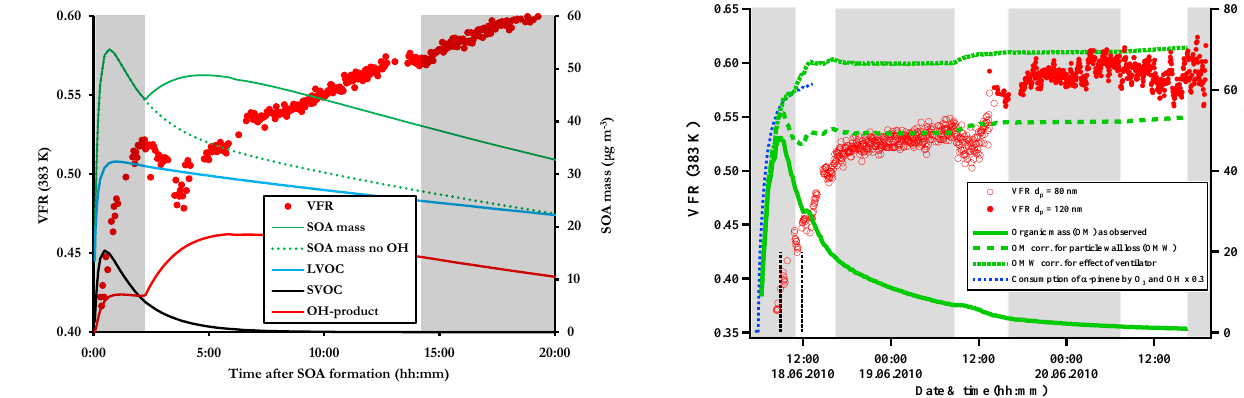
Fig. 5. VFR (383K) of 80nm and 120nm particles for α -pinene SOA produced in SAPHIR (SA10). The change in SOA mass with time before (green line) and after loss corrections without (green dashed line) and with ventilator on (green dotted line). The ventila- tor was switched on in the time interval between the black dashed lines. The white areas indicate when the roof was open and the re- action mixture was exposed to sunlight. The blue dotted line shows the turnover of α -pinene due to reaction with O 3 and OH, which was multiplied by 0.3 in order to estimate the contribution of α -pinene oxidation, compared to the oxidation of ozonolysis